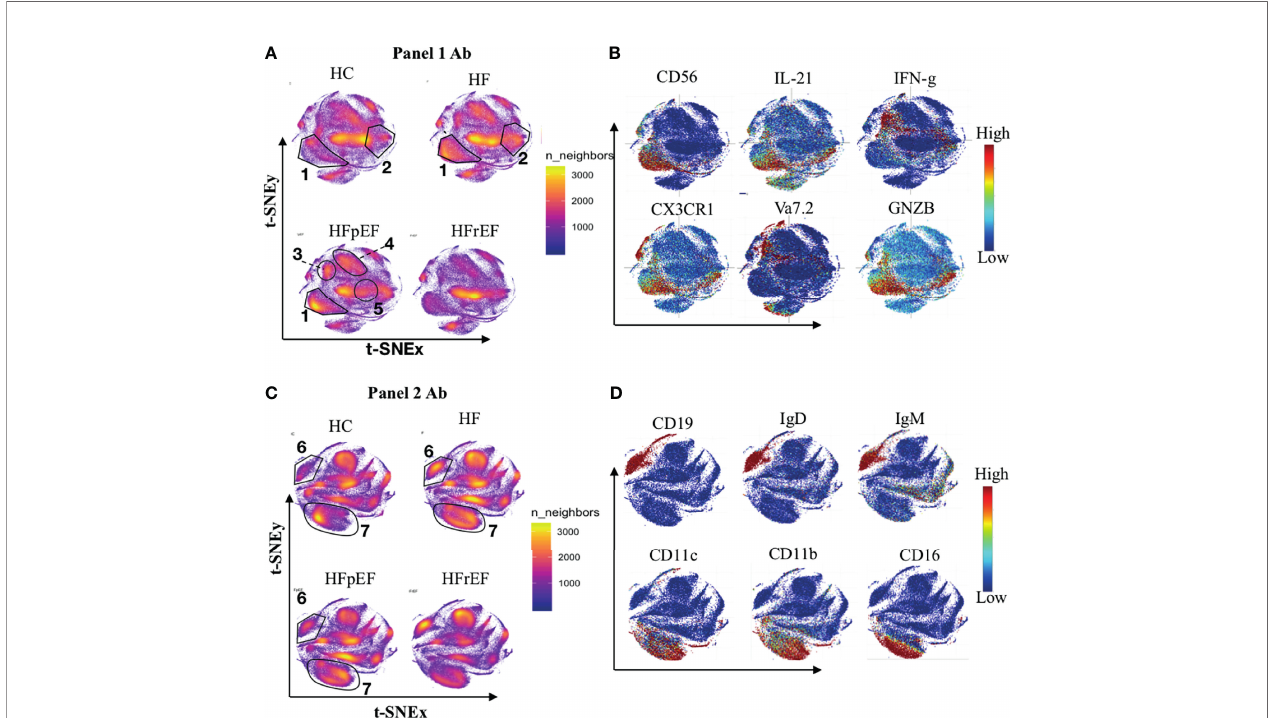
FIGURE 1 | Distribution of immune cells in healthy controls patients with history of heart failure (HF). Heart disease was further categorized based on left ventricular ejection fraction levels into preserve ejection fraction (pEF) or reduced ejection fraction (rEF). (A, C) Figure shows distribution of immune cell types on t-SNE density map. Area with higher number of cells are re fl ected as dense clouds of yellow colors. For normalization, 100k cells were randomly sample from each category (HC n=18, CHF n=32, HFpEF n=14, HFrEF n=14) for visualization. (B, D) Expression of markers were overplayed on t-SNE map to show the phenotype of immune cells. (A, B) Shows the results from Panel 1 antibody staining while (C, D) shows results from Panel 2 antibody